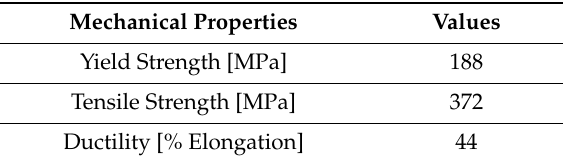
Table 2. Mechanical properties of the zinc coated steel sheet.